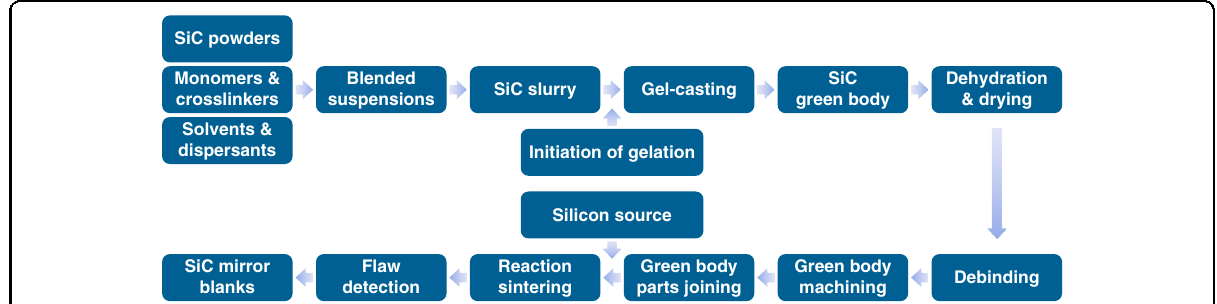
Fig. 3 The preparation procedure of the ⌀ 4.03m SiC mirror blank. A fl ow chart from powders to mirror blanks